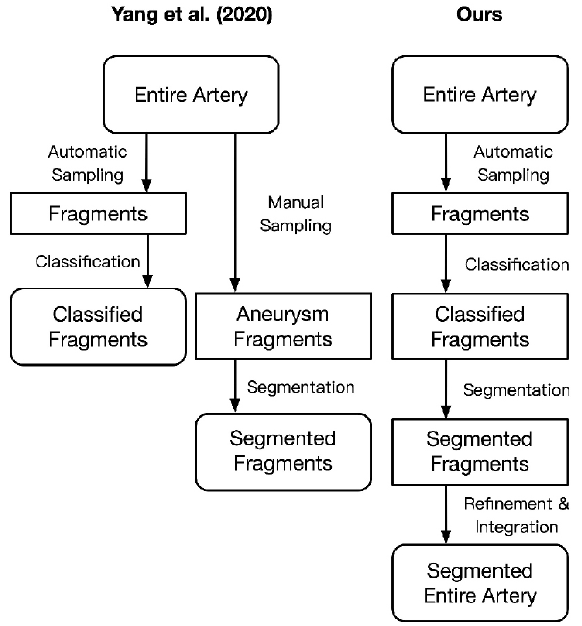
Fig. 1 Comparison of the pipelines of Yang et al. [7] and the proposed